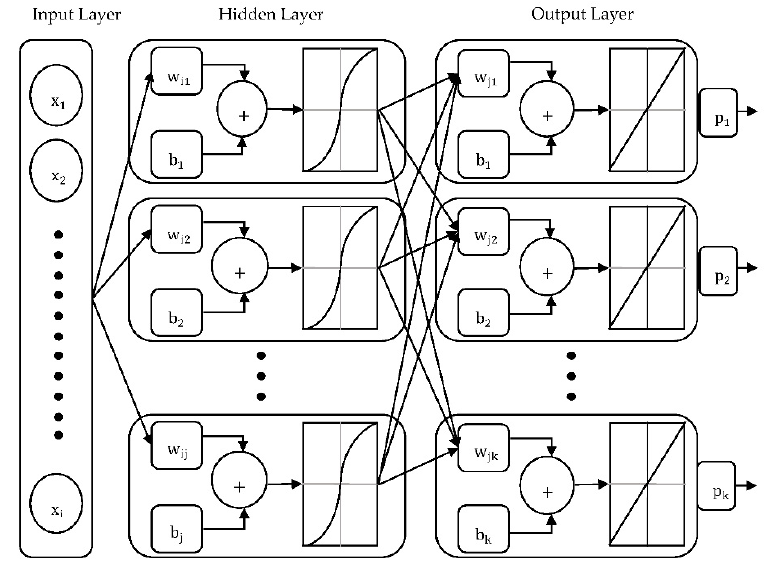
Figure 10. Schematic diagram of the multilayer perceptron neural network with one hidden layer.